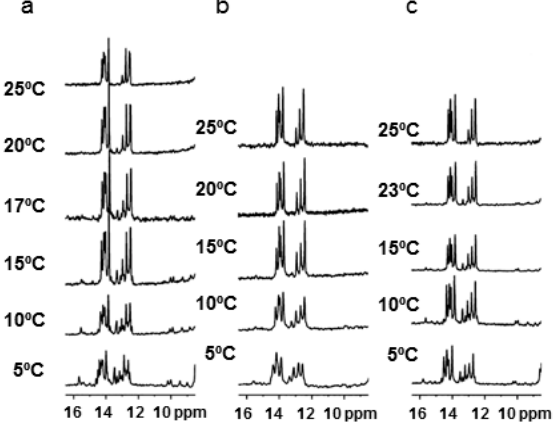
Figure 3. ( a ) 1 H-NMR spectra at different temperatures of the triplexes formed by the addition TFO DNA 1 to the hairpin 1 without cosolute; ( b ) in 20% EtOH; ( c ) in 20% of DMSO. Buffer 10 mM phosphate buffer, 100 mM NaCl pH 6.0.